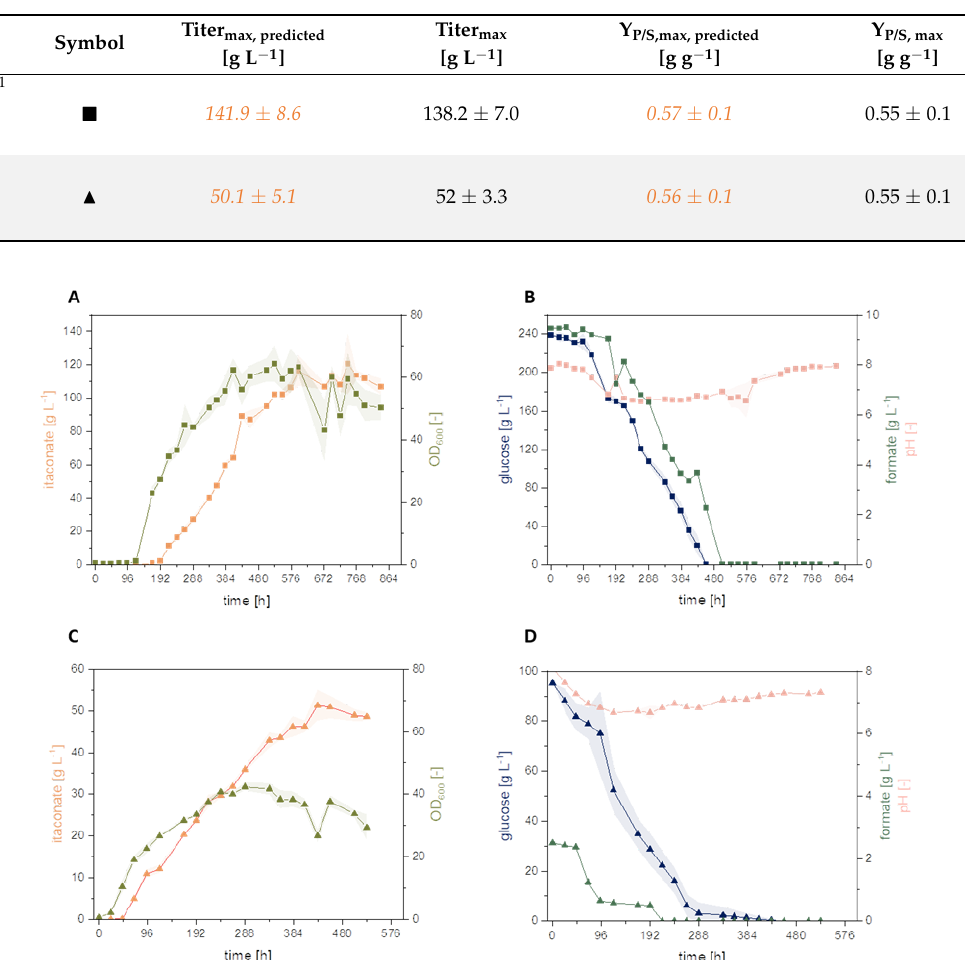
Table 5. Model validation experiments with U. cynodontis ∆ fuz7 ∆ cyp3 P etef mttA . ± values indicate the standard error of the mean ( n = 3). Model predictions are highlighted in orange whereas the experimental results are displayed in black. Symbols refer to conditions shown in Figure 6.